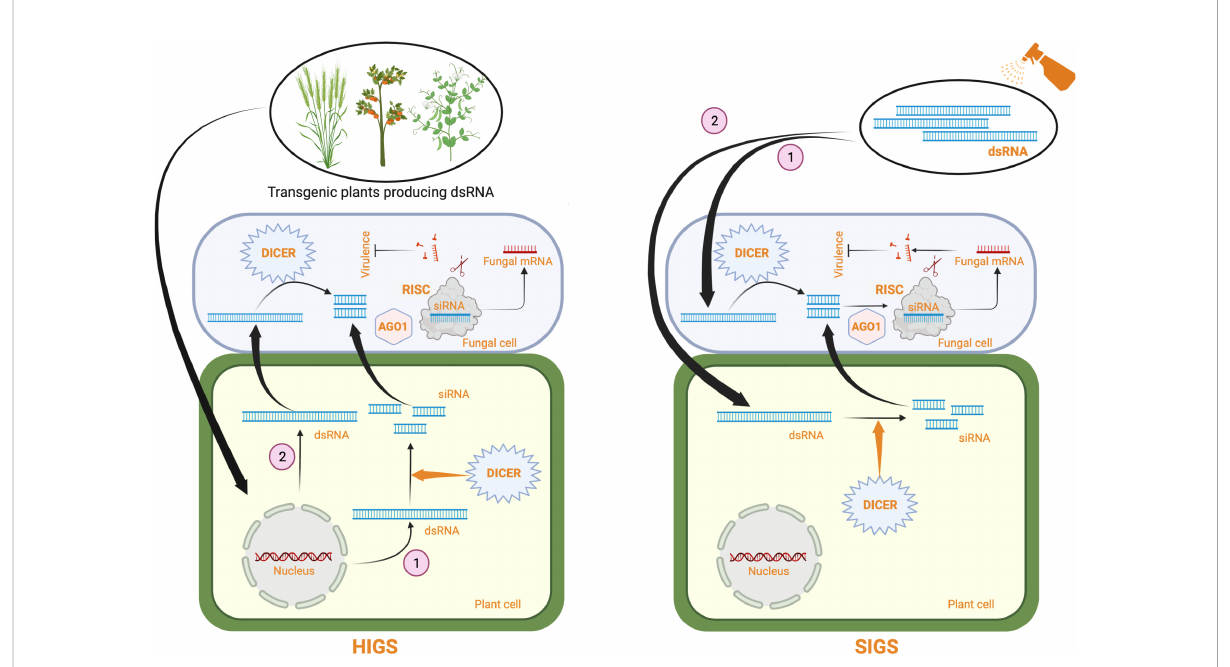
FIGURE 1 A schematic representing RNAi-based fungal control strategies in plants using dsRNA. In HIGS, a dsRNA producing construct speci fi c for an essential fungal gene is stably or transiently (not shown) expressed in plants. Some dsRNAs are processed by plant DICER proteins producing siRNAs (1) which are transferred to the fungal cell. Some dsRNAs are directly taken up by the fungal cell (2) and cleaved by pathogen DICER proteins. siRNAs produced are incorporated into the RISC complex through interaction with fungal argonaute (AGO1) proteins. The siRNA containing RISC complexes bind to the endogenous fungal target mRNAs based on sequence complementarity and degrade them, thus inhibiting pathogen growth and virulence. In SIGS, naked dsRNAs are directly sprayed on to the plant surface. The dsRNAs can directly go into the fungal cell where they are cleaved by fungal DICER proteins into siRNAs (1) or the dsRNAs can enter the plant cell where they are processed by plant DICER proteins into siRNAs and the resulting siRNAs are taken up by the fungal cell. The siRNAs degrade endogenous fungal target mRNAs through the same mechanism as described for HIGS, inhibiting fungal growth and virulence. Created with